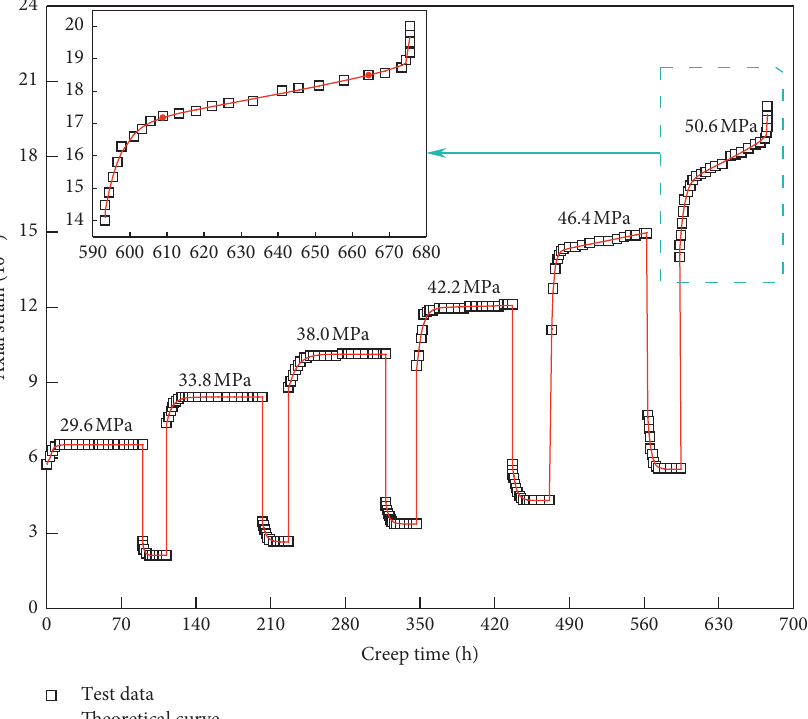
Figure 6: Comparisons between the nonlinear damage creep model and experimental curves at various deviatoric stresses for limestone